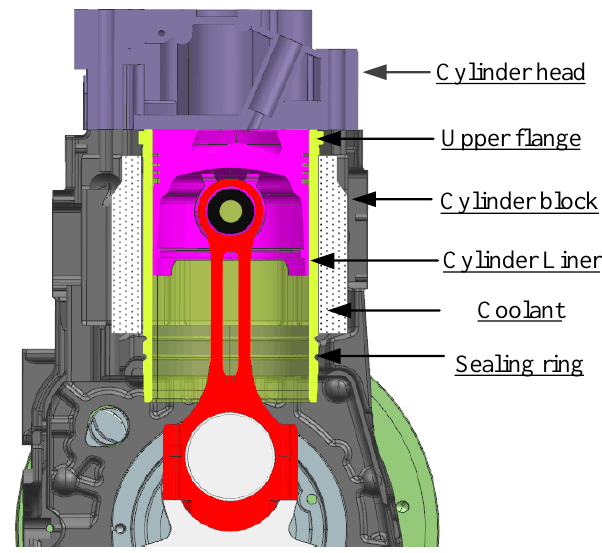
Figure 2. Construction of wet cylinder liner.